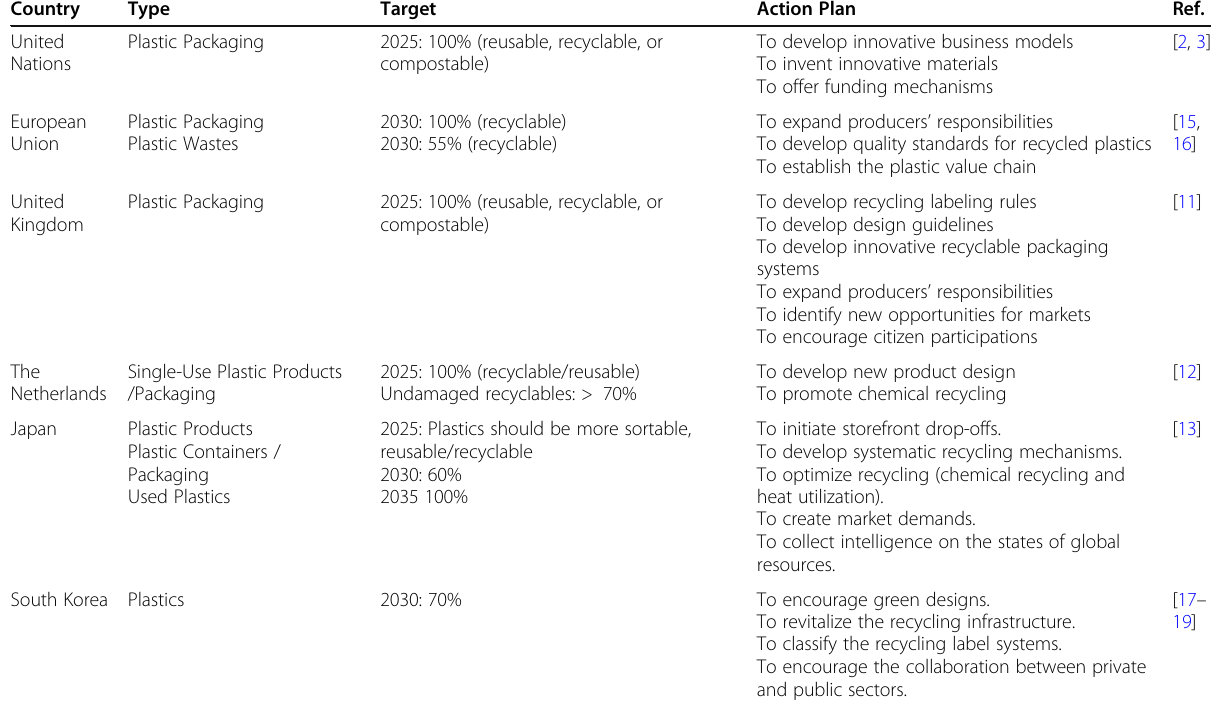
Table 2 International efforts on increasing the recycling targets of plastic wastes